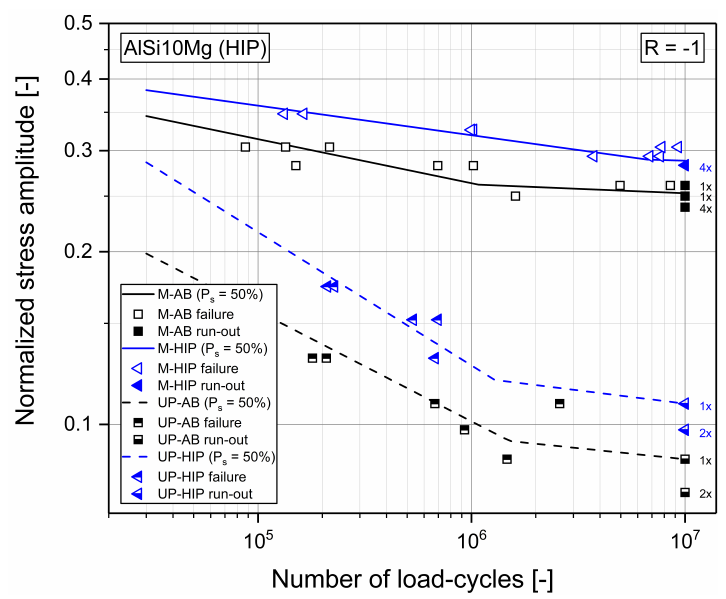
Figure 9. S/N curves for the AB and HIP test series.